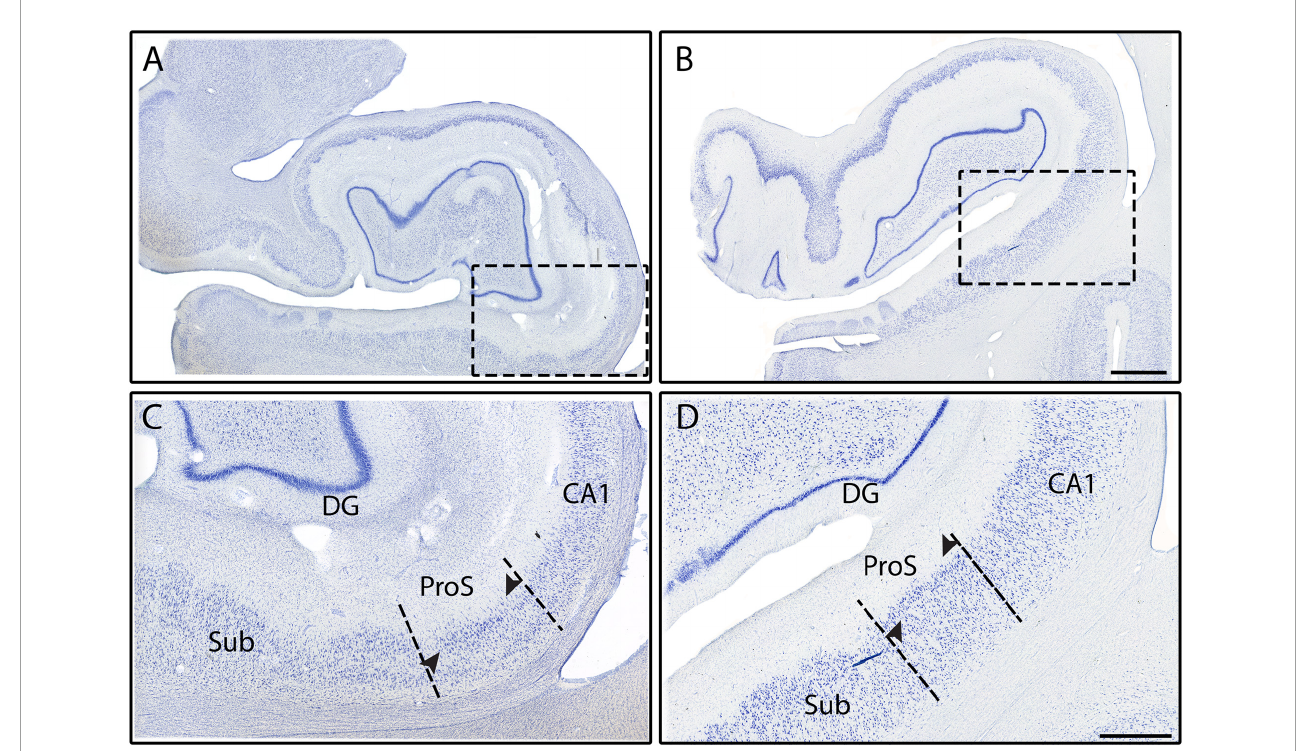
FIGURE4 Subfields CA1, ProS, and Sub from two different cases (Cases 18 and 6, respectively). Histologic slides illustrated at the full DG level with photomicrographs of two respective Nissl stained sections (A,B) , and zoomed mesoscale images (C,D) . Black dashed rectangles correspond to the close-up view of panels (C,D) , showing Sub, ProS, and CA1. Arrowheads point to the superficial neuronal clustering in the ProS pyramidal layer. Note the smaller and more densely packed neurons in ProS. Magnification bar for panels (A,B) : 2 mm, for panels (C,D) : 1 mm.